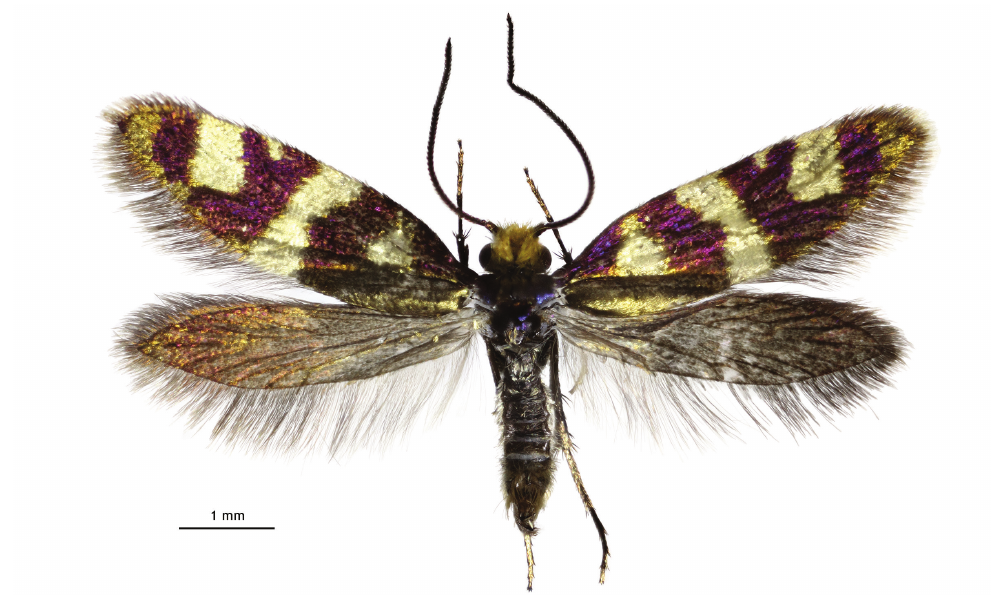
Figure 2. Micropterix facetella ,